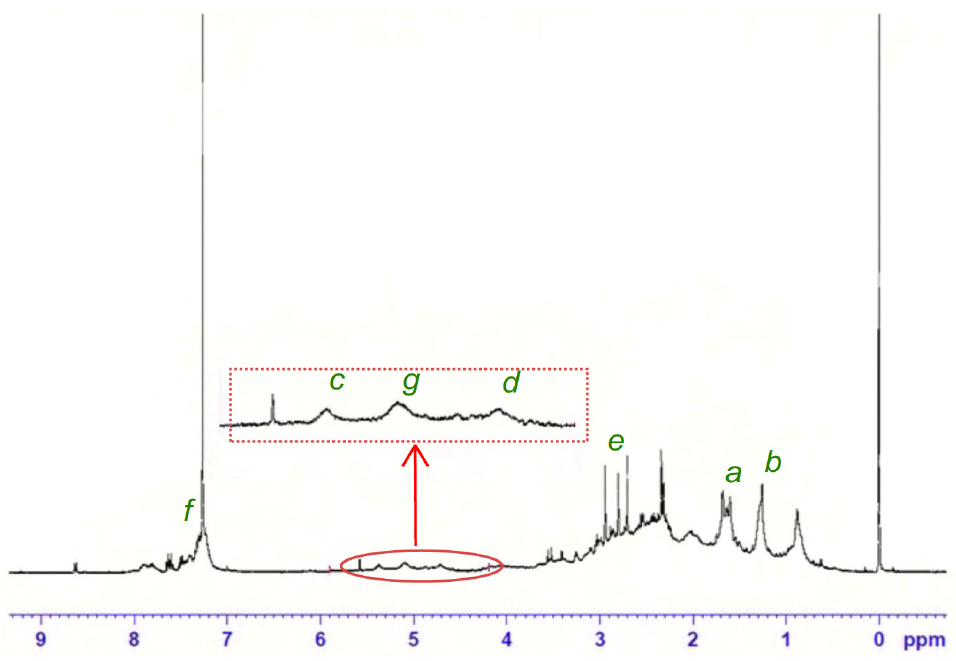
Figure 5. 1 H-NMR spectrum of the product of cationic polymerization of limonene with AlCl 3 as initiator.